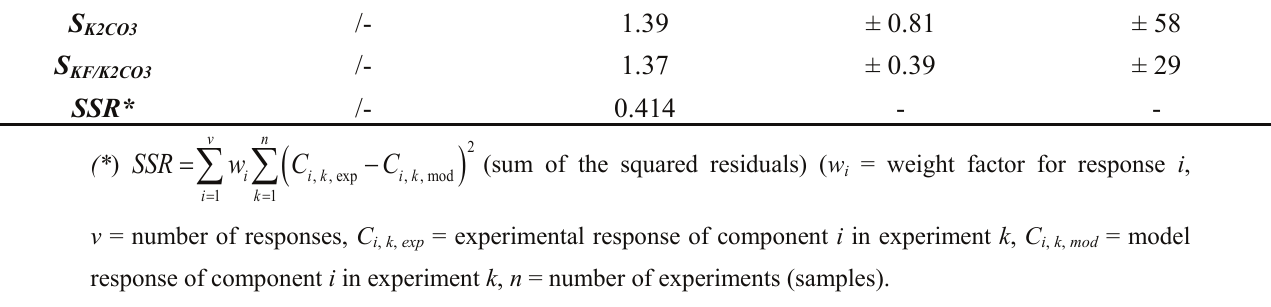
95% confidence range Value Relative/% i = weight factor for response i ,